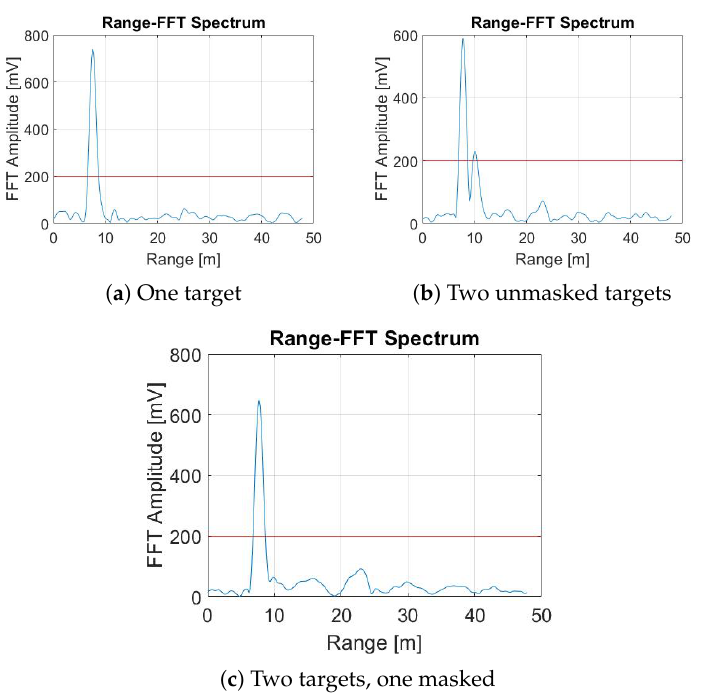
Figure 2. Range-FFT power spectrum. The horizontal red line is the target detection threshold. Radar is positioned 1.5 m from the floor. ( a ) Only target A ( d 1 = 7 m), ( b ) both targets A ( d 1 = 7 m) and B ( d 2 = 10 m) without shadowing effect, ( c ) target B ( d 2 = 10 m) shadowed by target A ( d 1 = 7